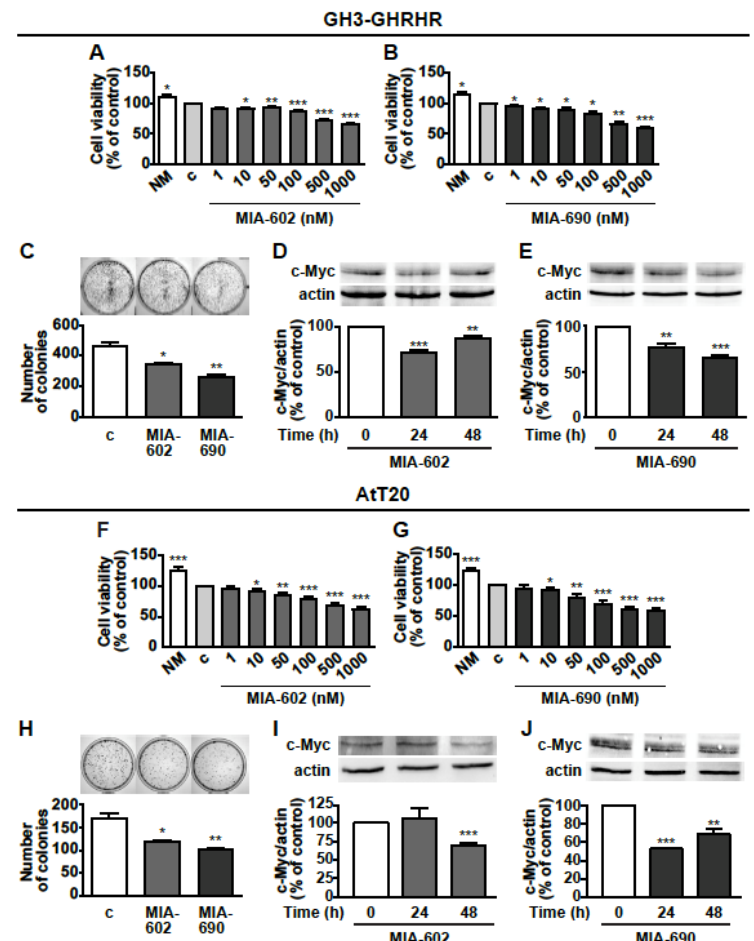
Figure 2. Inhibitory effects of GHRH antagonists in GH3-GHRH and AtT20 cells. Cell viability assessed by MTT in GH3-GHRH cultured in normal medium (NM) or in serum-deprived medium (c, control) for 24 h and with either MIA-602 ( A ) or MIA-690 ( B ), at the concentrations indicated. Results, expressed as percent of control are means ± SEM of three replicates. * p < 0.05, ** p < 0.01 and *** p < 0.001 vs. c by one-way ANOVA followed by Dunnet’s multiple comparison post-hoc test ( n = 4). ( C ) Representative colony formation in cells treated for 12 days either with or without 1 µ m MIA-602 or MIA-690. Results are means ± SEM. * p < 0.05, ** p < 0.01 vs. c by unpaired Student’s t -test ( n = 3). Representative Western blot for c-Myc in cells treated with 1 µ m MIA-602 ( D ) or MIA-690 ( E ) for the times indicated. Results, normalized to actin and expressed as percent of control (Time 0), are means ± SEM. ** p < 0.01, *** p < 0.001 vs. time 0, by unpaired Student’s t -test ( n = 3). Cell viability assessed by MTT in AtT20 cells cultured in normal medium (NM) or in serum-deprived medium (c, control) for 24 h and with either MIA-602 ( F ) or MIA-690 ( G ), at the concentrations indicated. Results, expressed as percent of control are means ± SEM of three replicates. * p < 0.05, ** p < 0.01 and *** p < 0.001 vs. c by one-way ANOVA followed by Dunnet’s multiple comparison post-hoc test ( n = 4). ( H ) Representative colony formation in cells untreated (c, control) or treated for 12 days with 1 µ m MIA-602 or MIA-690. Results are means ± SEM. * p < 0.05, ** p < 0.01 vs. c by unpaired Student’s t -test ( n = 3). Representative Western blot for c-Myc in cells treated with 1 µ m MIA-602 ( I ) or MIA-690 ( J ) for the times indicated. Results, normalized to actin and expressed as percent of control (Time 0), are means ± SEM. * p < 0.05, ** p < 0.01 and *** p < 0.001 by unpaired Student’s t -test ( n =